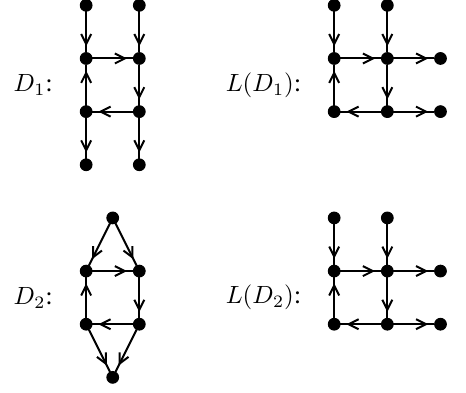
Figure 3: Two digraphs with the same line